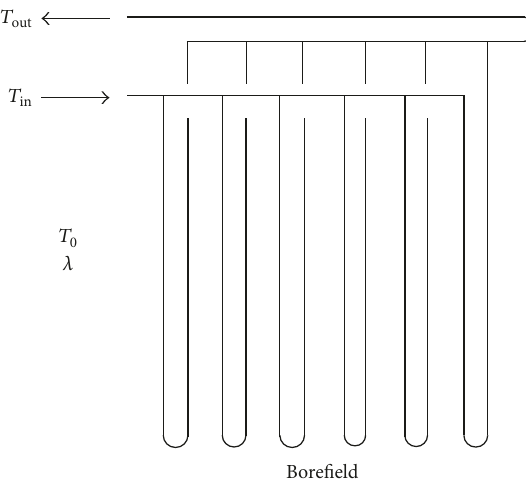
Figure 1: Schematic for multiborehole